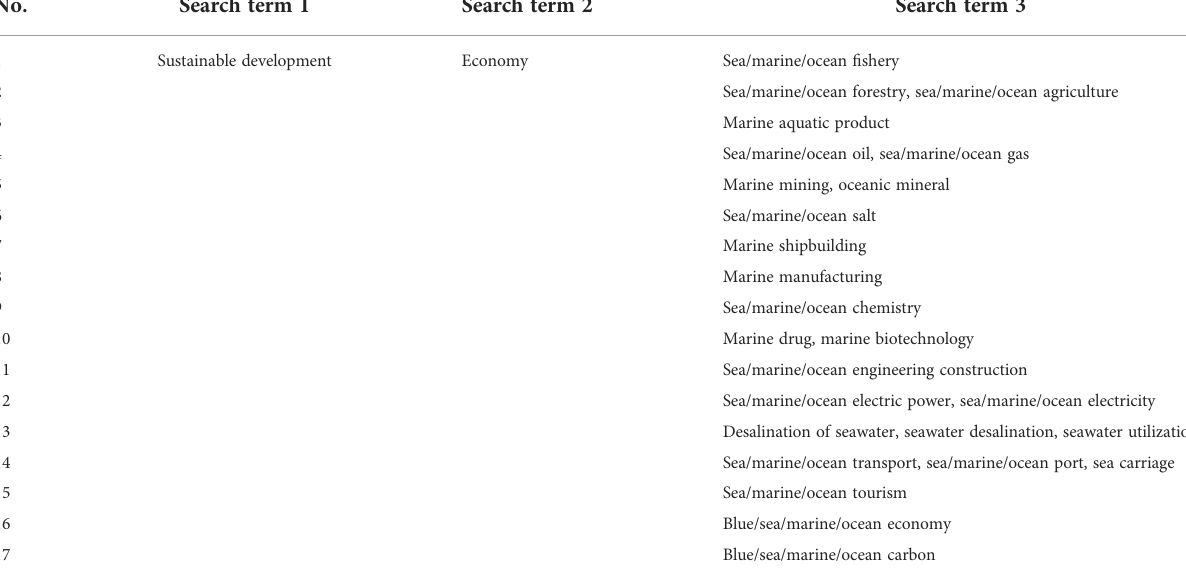
TABLE 1 Search terms of the database in this